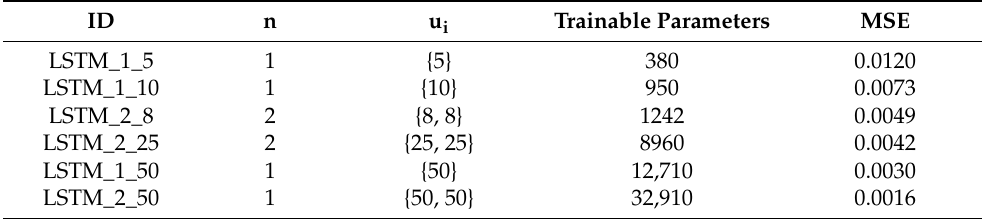
Table 4. List of evaluated Long Short-Term Memory (LSTM) network topologies, described by the number of hidden layers n abd the number of LSTM units per layer u i , and the mean squared errors (MSE) produced in the validation